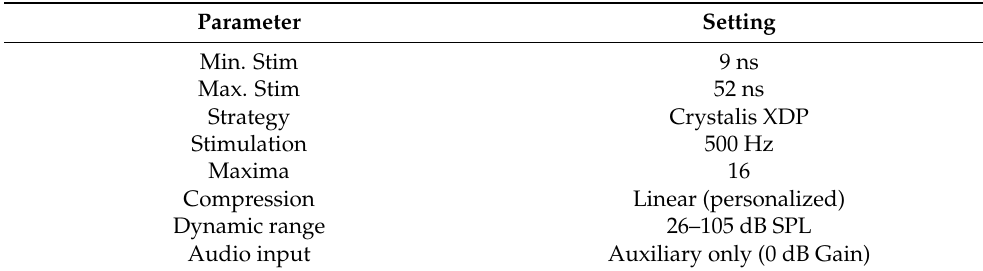
Table 3. Sound processor settings while measuring the “activation